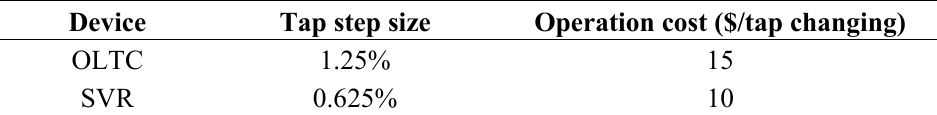
Table 5. Major data of the OLTC and SVR.